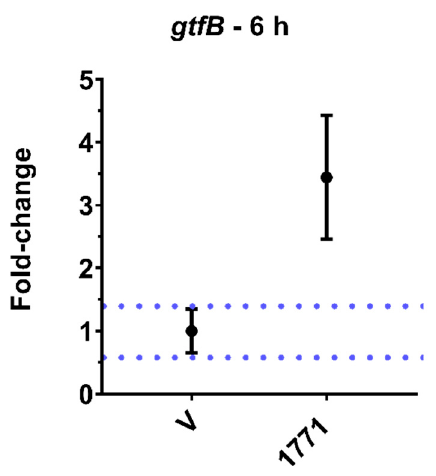
Figure A3. S. mutans gtfB expression of planktonic cultures. The central data are the mean, and the error bars are the confidence interval (95% CI). The dotted lines use vehicle data to compare the effectiveness of tested treatments.